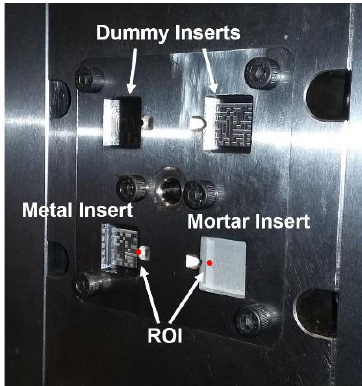
Figure 5. Metal insert and mortar insert being mounted on the injection mould. Picture taken prior to injection moulding. ROI: region of interest. Each of the four cavities has nominal dimensions of 12 mm × 12 mm.